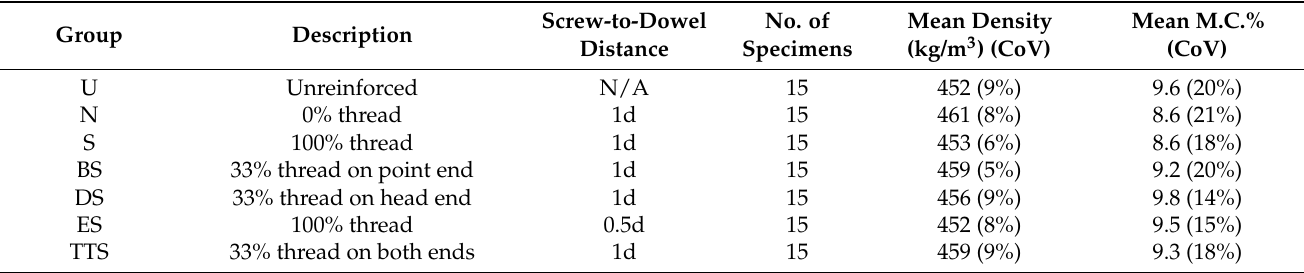
Figure 2. Embedment-strength test set-up. Table 1. Summary of each group in the embedment-strength test [31]. Table 1. Summary of each group in the embedment-strength test